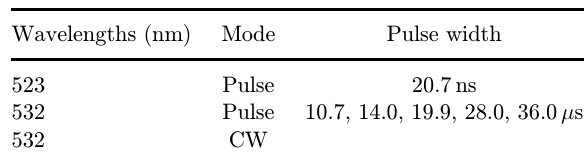
Table 1. Pulse widths of excitation lasers.